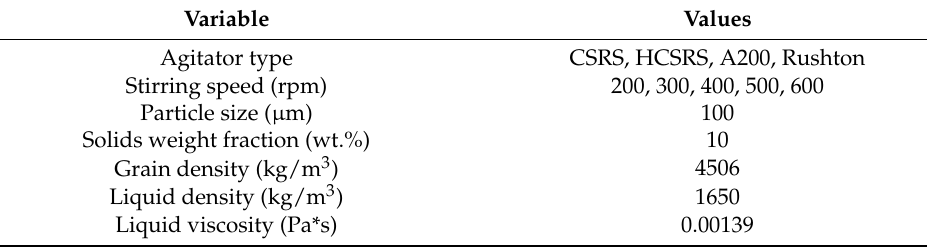
Table 2. Operating conditions and physical